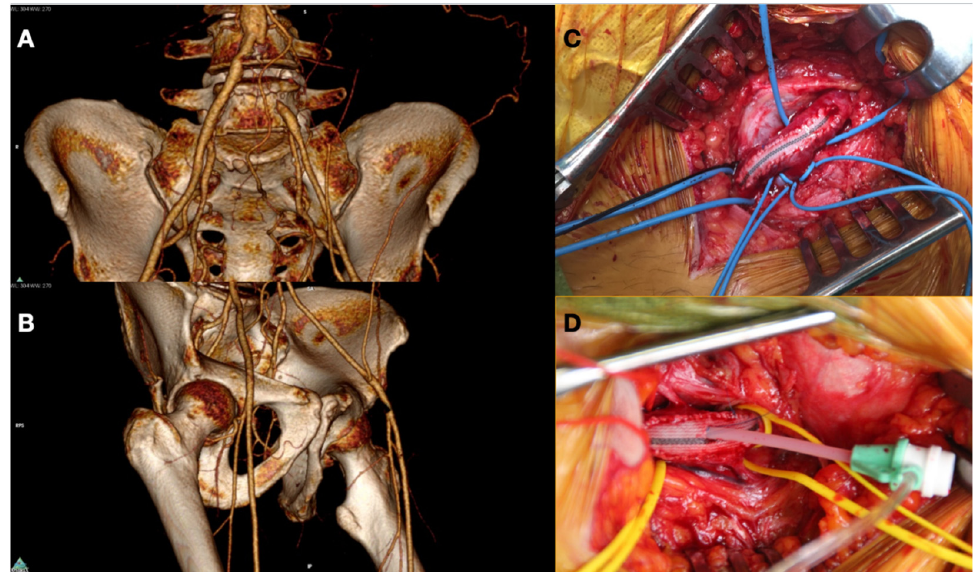
Figure 5. Preoperative CT Angiography showing occlusion in left Common Iliac Artery ( A ) and critical stenosis in Common Femoral Artery ( B ). Puncture of Common Femoral Artery after endarterectomy and Dacron patch angioplasty ( C ) with placement of sheath to perform a treatment of iliac lesion ( D ).